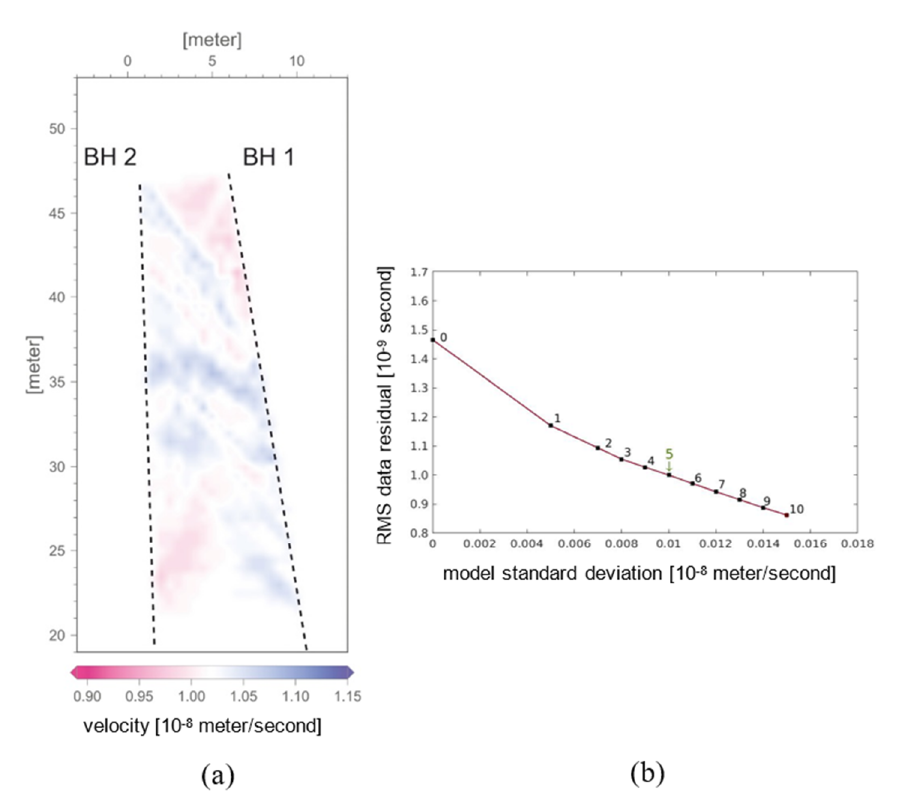
Figure 3. ( a ) Tomographic image of borehole pair 1–2 after the 5th iteration. ( b ) Data variance vs. model complexity. The data residual is decreasing with each iteration. We chose to stop the inversion after five iterations; now, the residual is in the same order as the selection inaccuracy of our data.